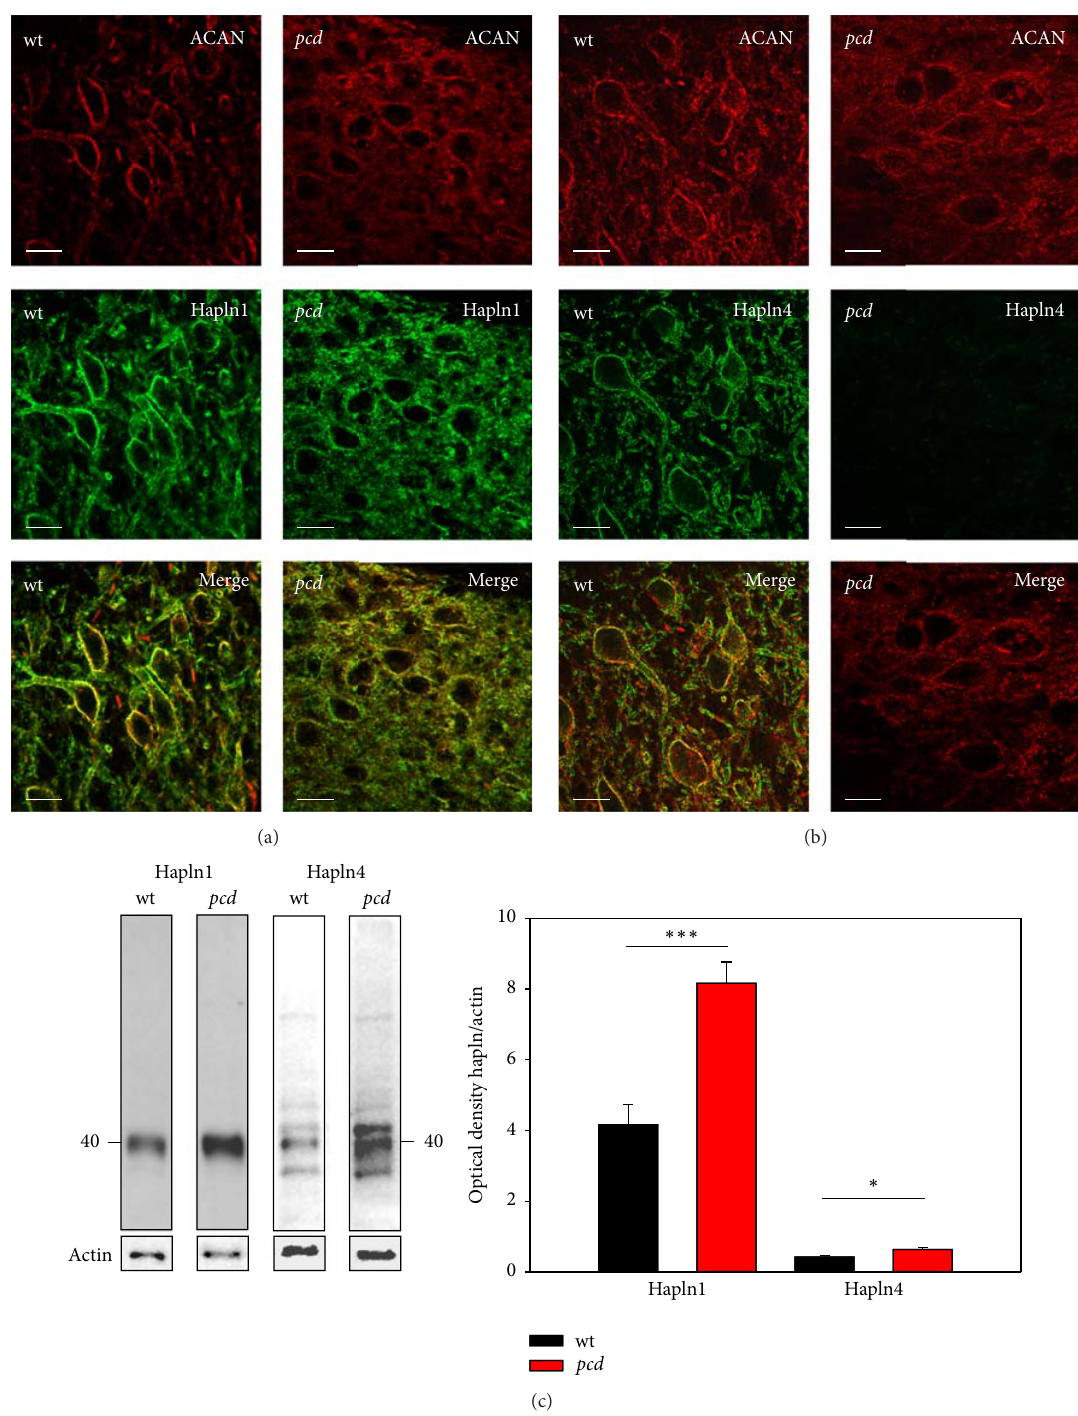
Figure5:ComparisonoflinkproteinexpressioninDCN.DCNneuronsarevisualizedbyaggrecanimmunoreaction(red).(a)Hapln1labeling (green)surroundstheDCNneuronsinbothgenotypes,matchingtheaggrecanimmunoreactivity;additionallyin pcd